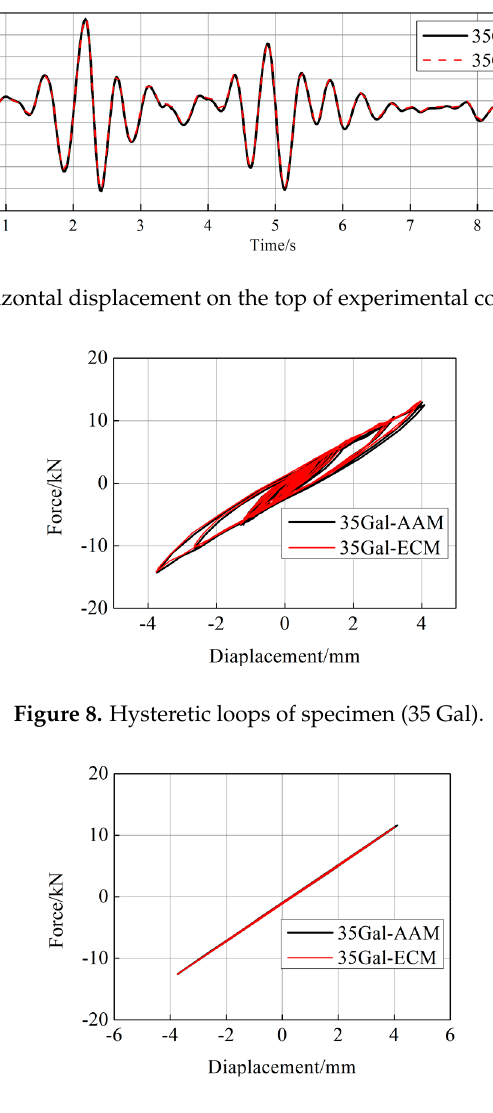
Figure 10. Horizontal displacement on the top of experimental column (220 Gal).